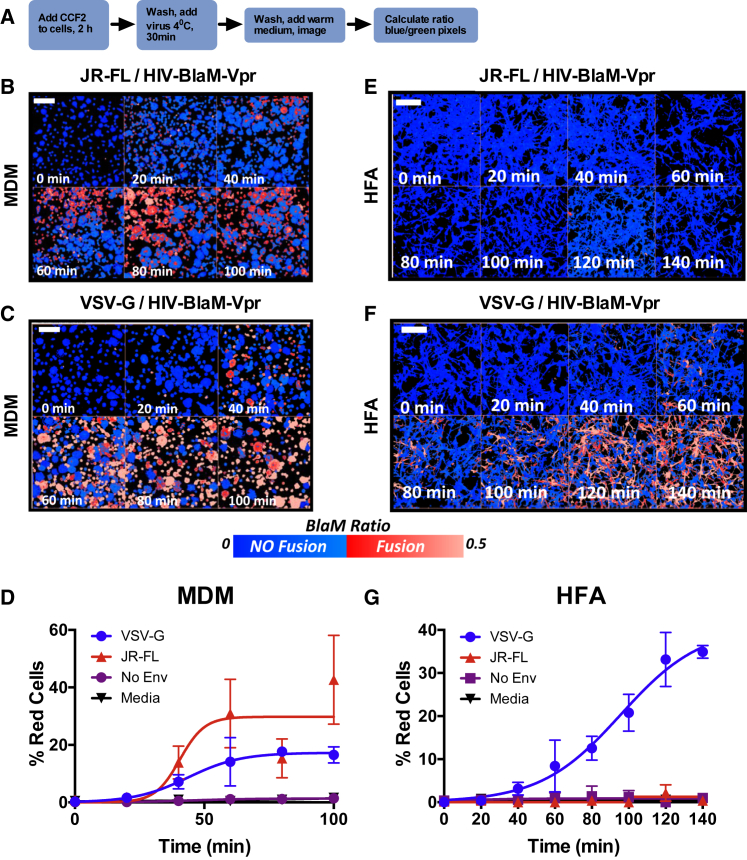
Live-Cell Fusion Assay Does Not Detect HIV-1 Env Fusion with HFAs(A) Experimental plan.(B and C) CCF2-loaded MDMs exposed to HIV-1 BlaM-Vpr pseudotyped with HIV-1 JRFL (B) or VSV-G Env (C) were imaged at the times shown.(D) Quantified results from (B) and (C) showing the percentage of red cells as a function of time with the sigmoidal curve fit. Mean of three independent experiments ± SD using three MDM donors.(E and F) CCF2-loaded HFAs exposed to HIV-1 BlaM-Vpr pseudotyped with HIV-1 JRFL (E) or VSV-G Env (F) were imaged at the times shown.(G) Quantified results from (E) and (F), showing the percentage of red cells as a function of time with the sigmoidal curve fit. Mean of three independent experiments ± SD.Blue pseudocolor represents no fusion; red represents fusion. Scale bar, 70 μm.